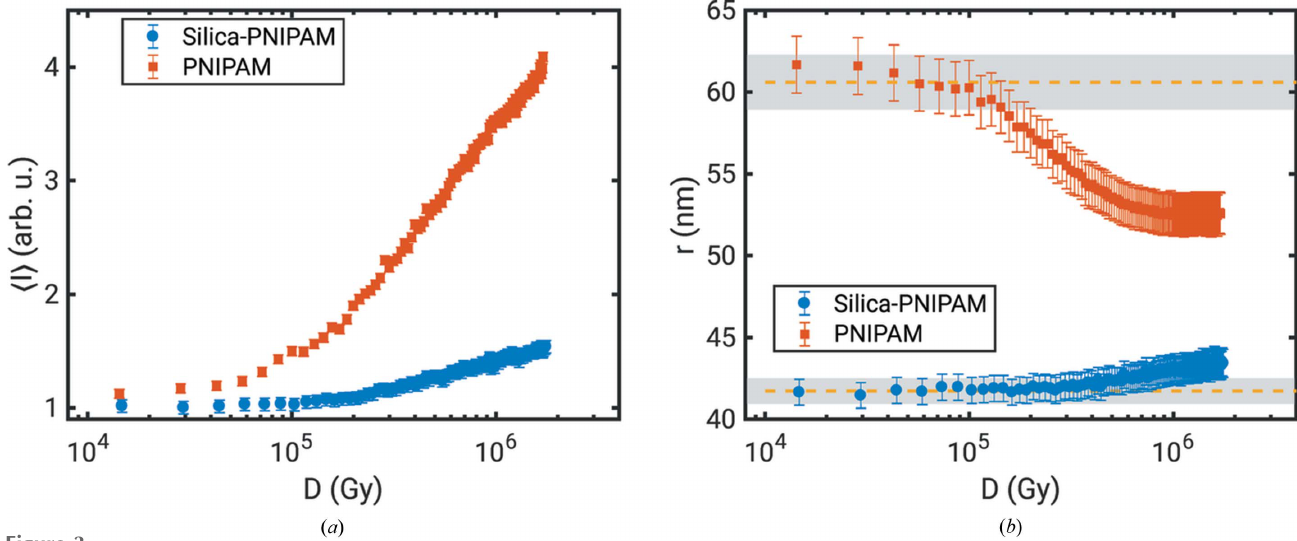
Figure 3 Effect of radiation damage on ( a ) the averaged intensity h I i normalized to the measurement at D ¼ 0 Gy and ( b ) the particle radius r for both samples. The dashed lines in the bottom part mark the radius obtained from the first patterns of the series, i.e. for D ¼ 0 Gy, the grey areas mark the error bar of those